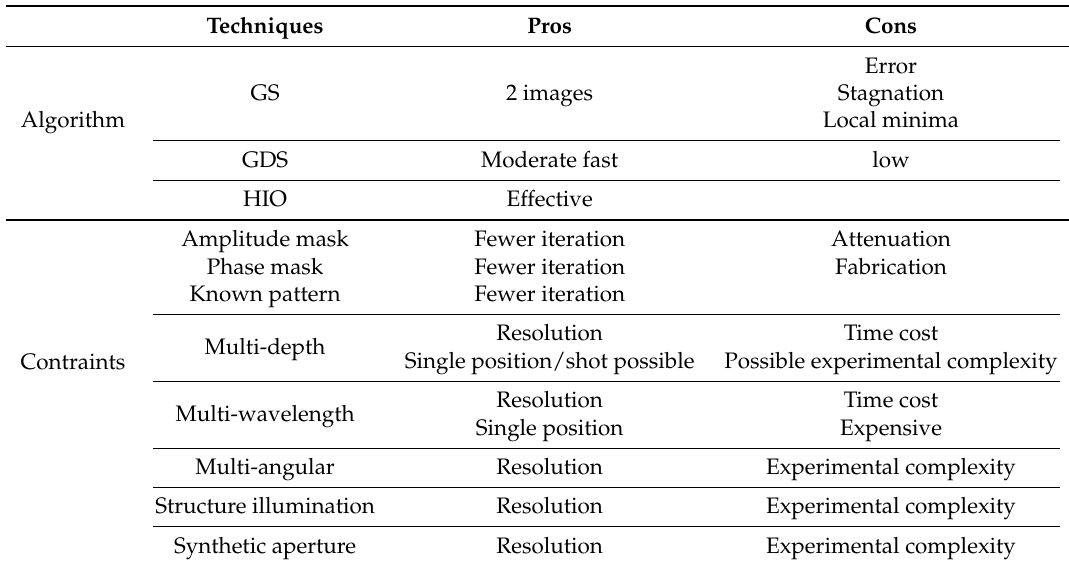
Table 2. Comparison of iterative phase retrieval